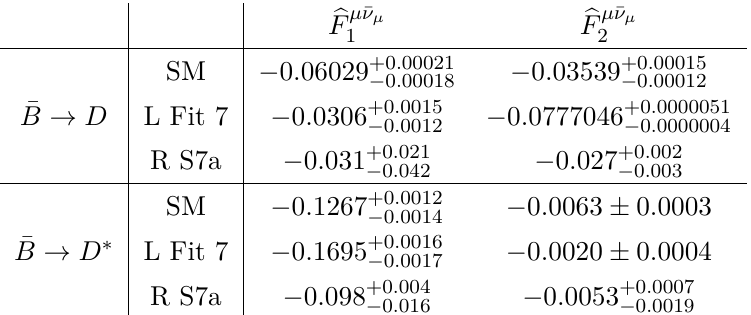
Table 4 . Predictions for the angular moments b F µ ¯ ν µ in the SM and the same NP scenarios considered in table 3.